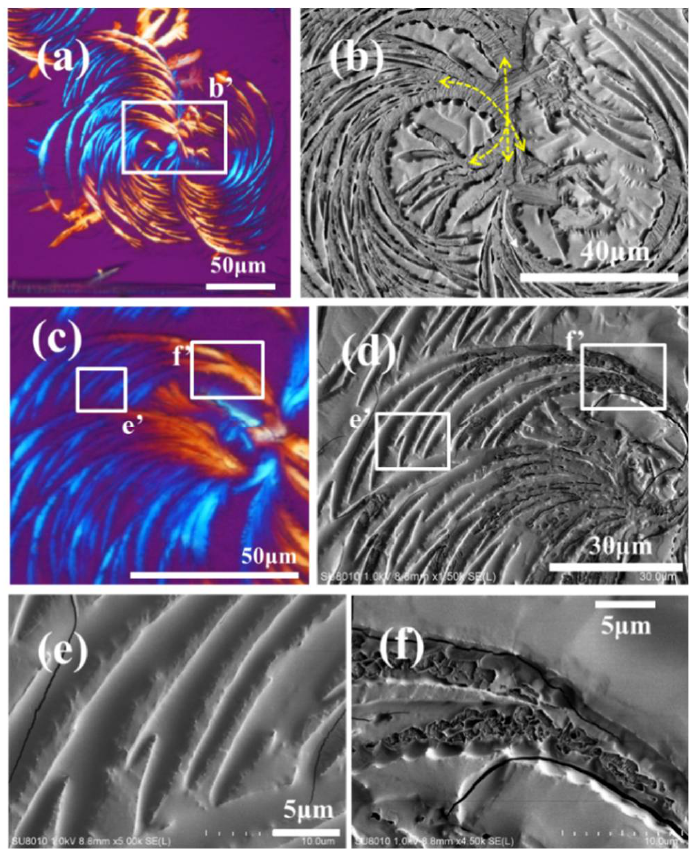
Figure 13. ( a , c ) POM and ( b , d – f ) SEM micrograph of (S)-MA/PVPh: ( e , f ) zoomed-in images of the squared regions—e’ and f’ in ( c ) (50/50) blend crystallized at T c = 65 °C.